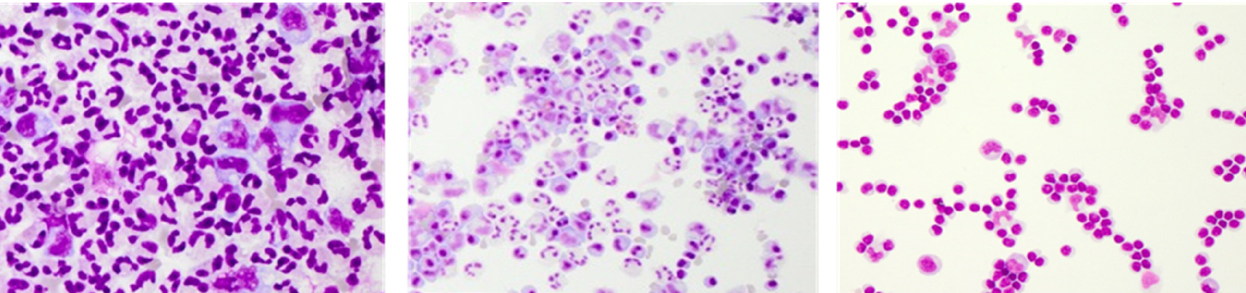
Figure 3. Representative May–Grünwald stained CSF cytology images of bacterial meningitis ( left ), viral meningitis ( middle ), and an autoimmune central nervous system (CNS) disease ( right ). Cytol-